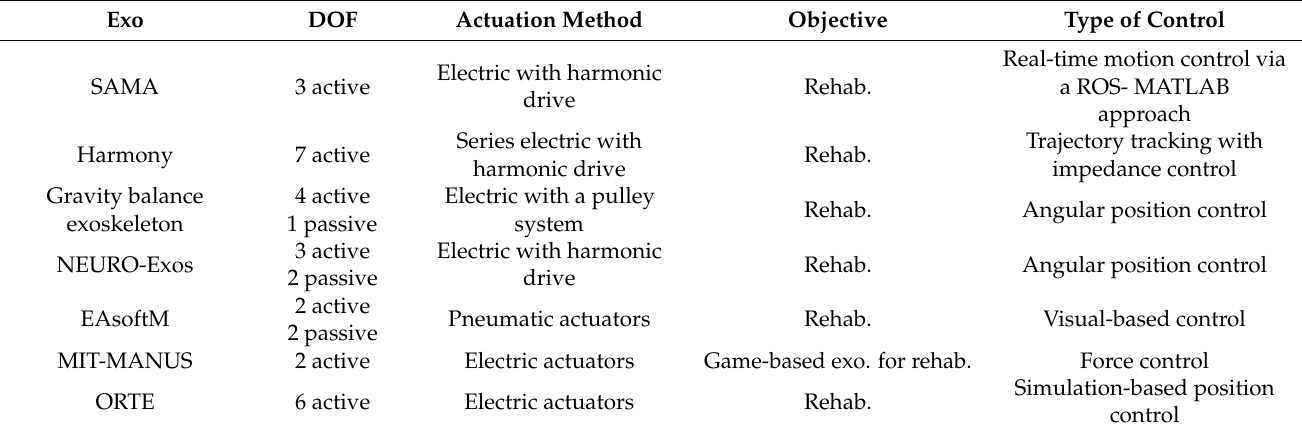
Table 8. Comparison of SAMA exoskeleton against similar upper-limb